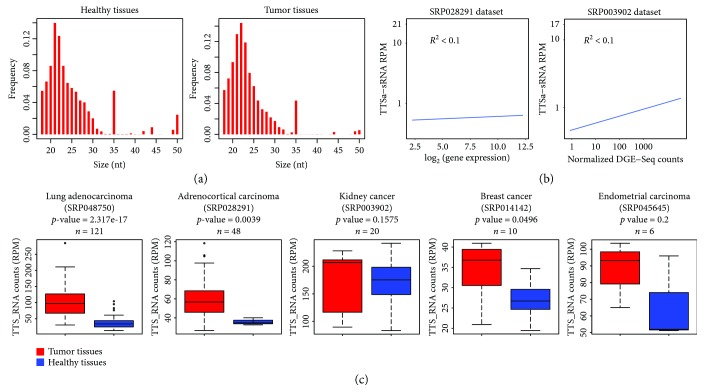
TTSa-RNAs are overexpressed in cancerous tissues compared to matched controls. (a) Size distribution of TTSa-RNAs from primary samples (healthy tissues, left panel; cancerous tissues, right panel). (b) Correlation between mRNA expression level and abundance of TTSa-RNAs in SRP028291 and SRP003902 datasets. Each dot represents a single gene in a single sample. (c) TTSa-RNA expression (RPM) in different tumor types compared to matched control tissues.